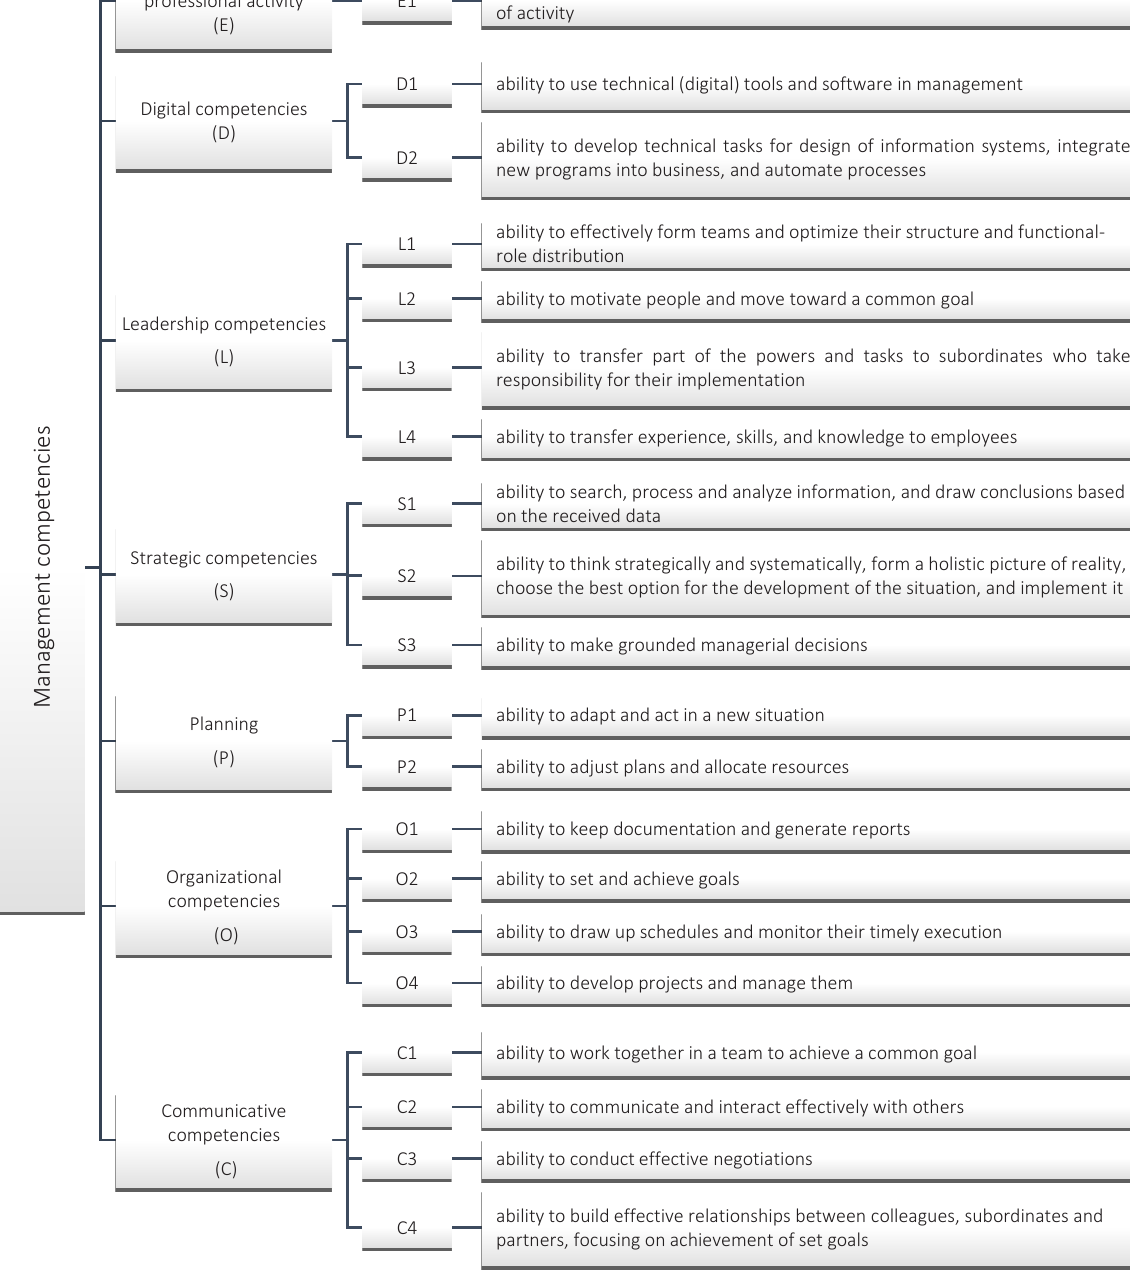
Figure 6. Model of managerial